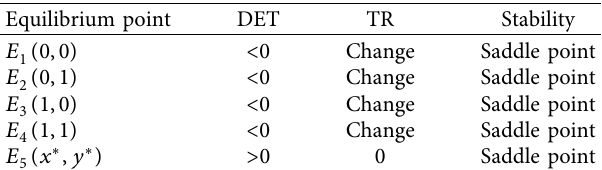
Table 8: Stability analysis of strategy system ( f ) of the government and